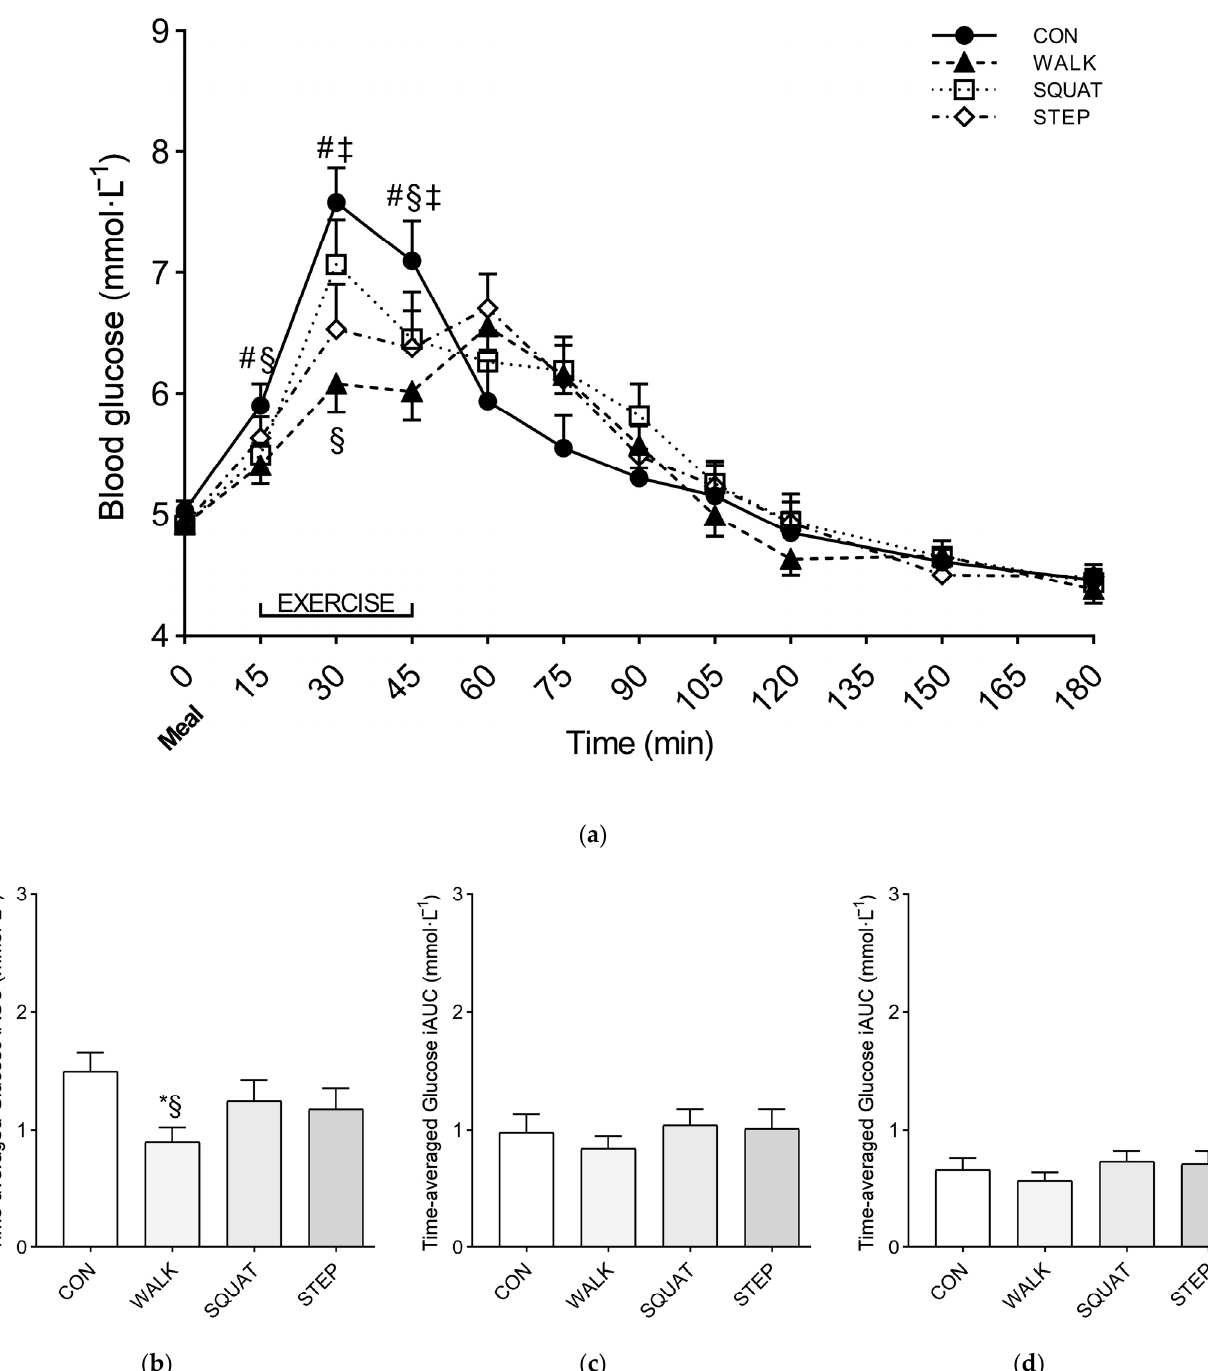
Figure 2. Glucose response over time ( a ) and time-averaged glucose iAUC at 0–60 h ( b ), 0–120 h ( c ), 0–180 h, and ( d ) after the meal, for Study 1. Symbols: *, p < 0.05 vs. CON; #, p < 0.05 vs. WALK; §, p < 0.05 vs. SQUAT; ‡, p < 0.05 vs. STEP. Values are reported as mean (± SEM). Significant differences between conditions were found for the time-averaged positive iAUC at 0–60 min ( p = 0.027, η p 2 = 0.278). Specifically, significant reductions of the iAUC were found for WALK (0.90 ± 0.43 mmol·L − 1 ) compared with CON (1.49 ± 0.55 mmol·L − 1 ) and SQUAT (1.24 ± 0.63 mmol·L − 1 ) ( p < 0.001 and p = 0.046, respectively). Conversely, no